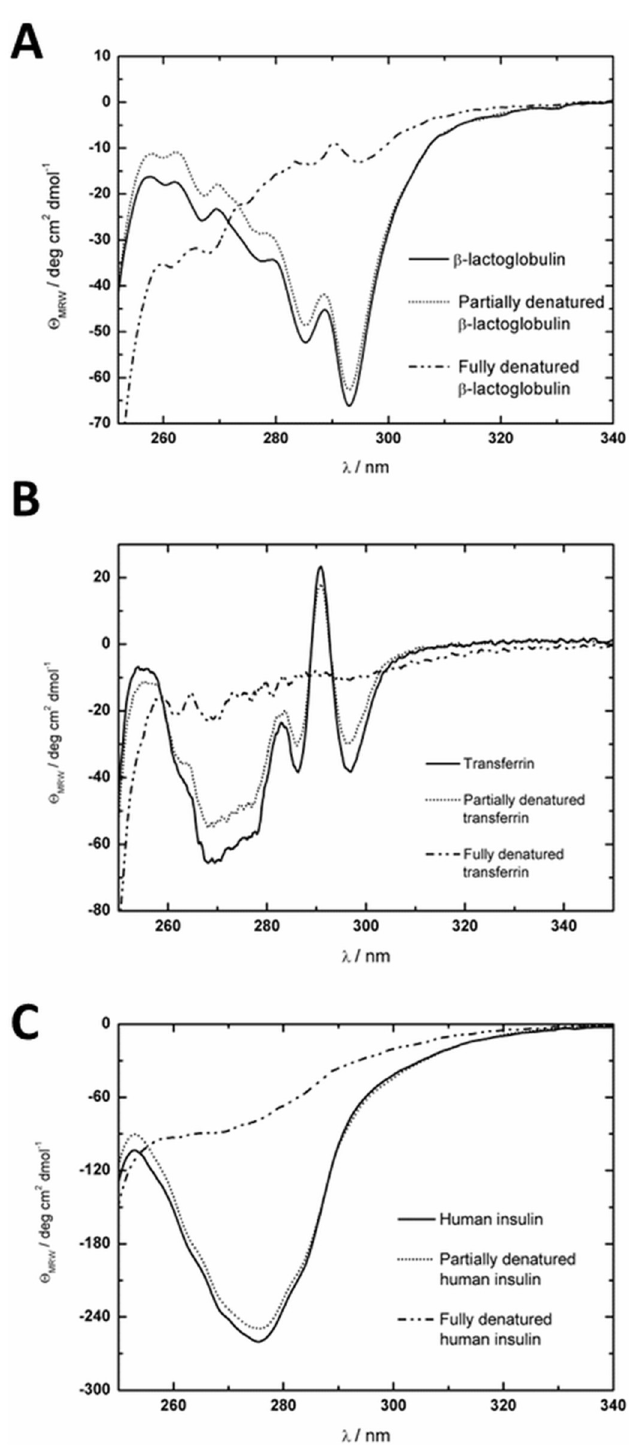
Fig 3. ECD spectra showingchangesin the tertiary structure of β -lactoglobulin(A), transferrin (B) and human insulin(C) with increasing surfactant concentration. For β -lactoglobulinand transferrin the concentrations of SDS were 4.3 x 10 − 4 M and 8.7 x 10 − 2 M for partially and fully denaturedprotein, respectively. For insulinthe concentrations of SDS were 2.3 x 10 − 4 M and 8.7 x 10 − 2 M for partially and fully denaturedprotein,